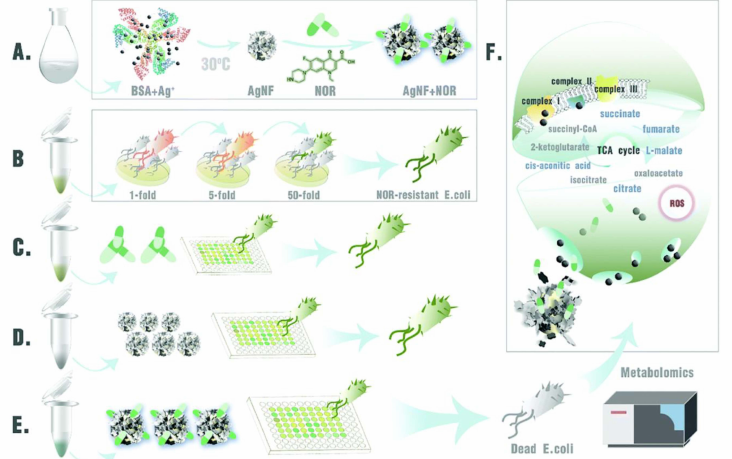
Figure 8. Schematic illustration of the antibacterial mechanism of antibiotic-loaded silver nano flowers (Ag NFs). ( A ) Synthesis of Ag NFs. ( B ) Evolutionary process of NOR-resistant strains. ( C ) Norfloxacin (NOR) alone does not eradicate NOR-resistant E. coli . ( D ) Ag NFs alone cannot eradicate NOR-resistant E. coli . ( E ) Combination of Ag NFs and NOR eradicates NOR-resistant E. coli . ( F ) Metabolomic studies revealed that the combination of Ag NFs and antibiotics combined improved the antimicrobial effect through the release of silver ions and stimulation of the TCA cycle (five upregulated metabolites in the TCA cycle are marked in